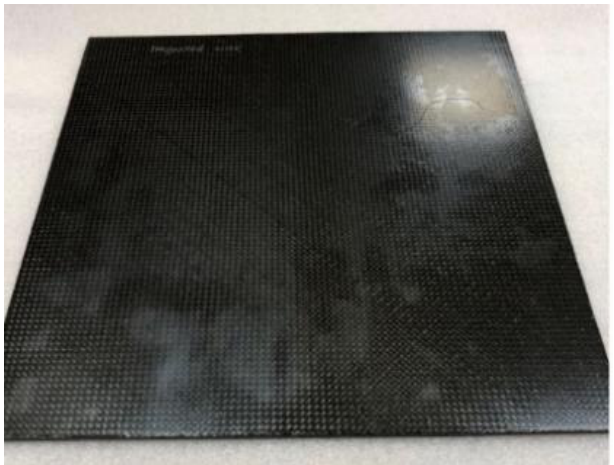
Figure 2. Reference test panel (L_ref). Dimensions: 300 mm × 300 mm.